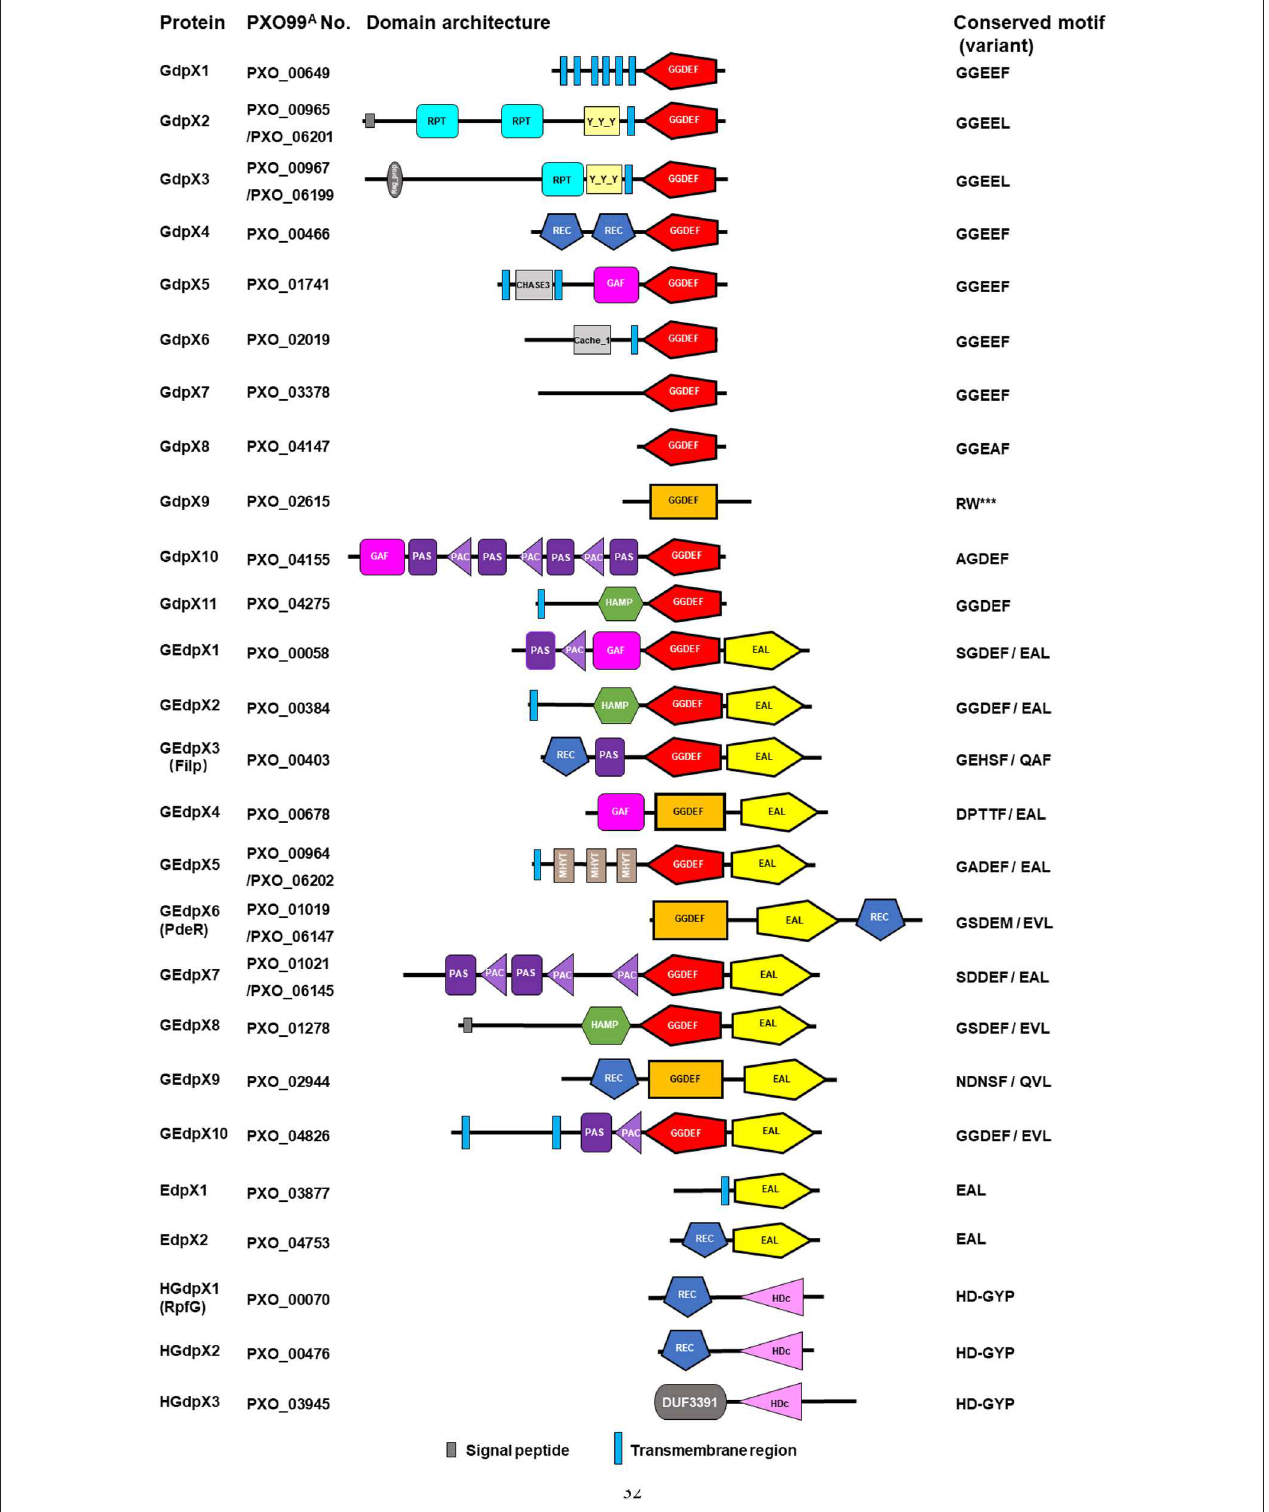
FIGURE 1 | Identification of GGDEF, EAL and HD-GYP domain architecture and conserved motif in Xanthomonas oryzae pv. oryzae. Simple Modular Architecture Research Tool (SMART) (http://smart.embl-heidelberg.de/) was used to analyze the domains. The GGDEF domains implicated in c-di-GMP synthesis were shown in red, while the degenerate GGDEF domains in rectangle were predicted by SMART only with the Pfam database and displayed in orange. The EAL and HD-GYP domains implicated in c-di-GMP hydrolysis are illustrated in yellow and pink, respectively. ***means amino acid deficiency when compared with homologous proteins.